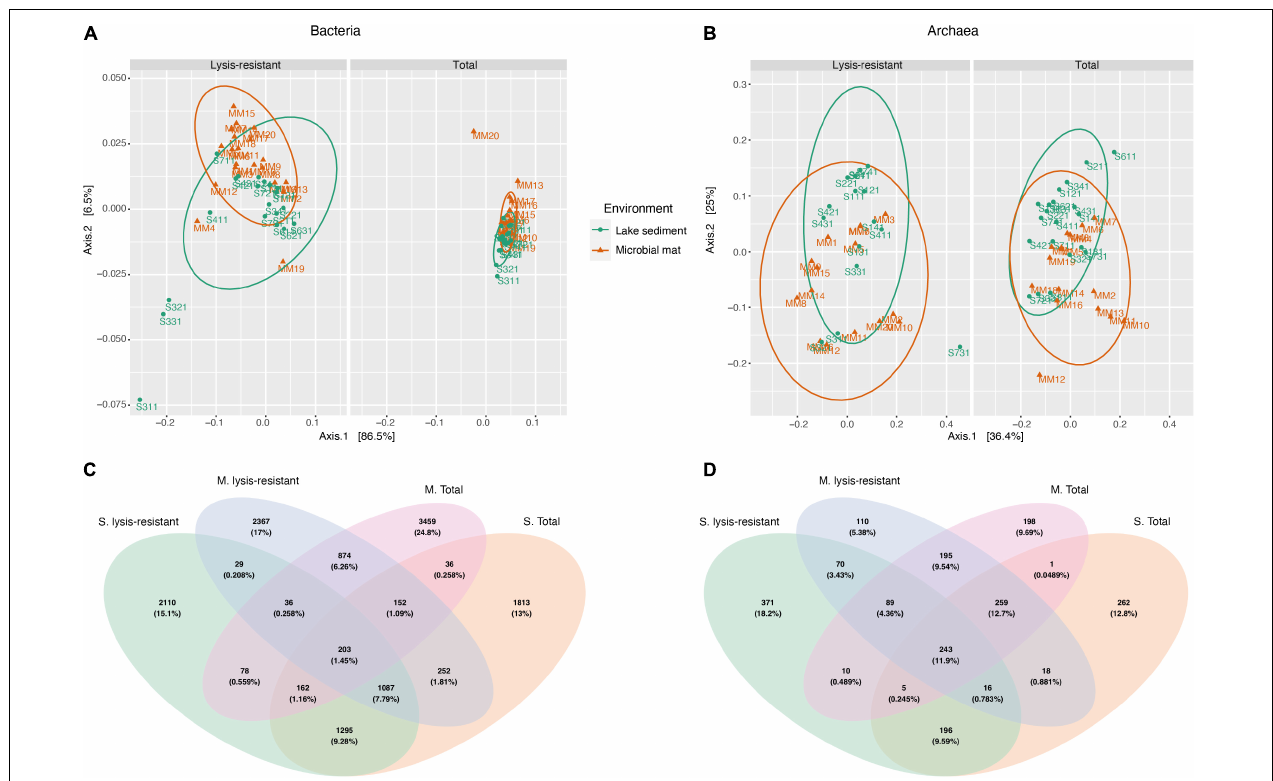
FIGURE 2 | Principal coordinate analysis (PCoA) and Venn diagram of the bacteria and archaea community. (A) Weighted UniFrac PCoA of the bacterial community comparing microbial mats (in orange) and lake sediments (in green) in the lysis-resistant (left) and total fractions (right). The ellipses show a 95% confidence level per group. (B) PCoA of the archaeal community comparing microbial mats (in orange) and lake sediments (in green) in the lysis-resistant (left) and total fractions (right). The ellipses show a 95% confidence level per group. (C) Venn diagram of the bacterial community (top 5,000 of 15,300 ASVs) comparing both environments (M, microbial mats; S, lake sediments) and both community fractions (lysis-resistant and total community). (D) Venn diagram of the archaeal community (top 1,000 of 2,128 ASVs) comparing both environments (M, microbial mats; S, lake sediments) and both community fractions (lysis-resistant and total